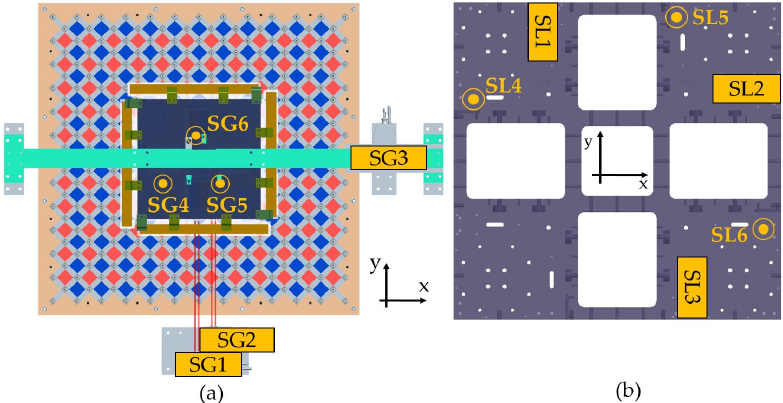
Figure 7. Arrangement of the motion feedback sensors: ( a ) global sensors for the fine stage, ( b ) local sensors for the coarse stage. Table 6. Specifications of the sensors